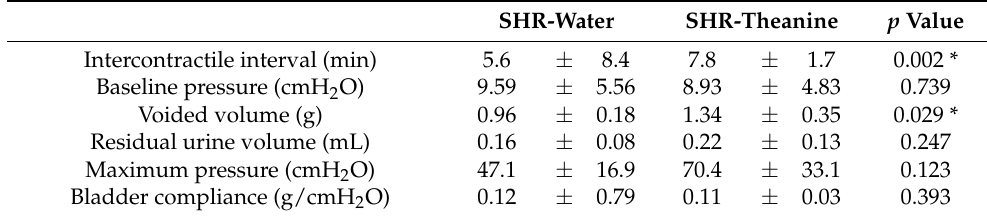
Table 3. Cystometory parameters in the SHR–water and SHR–theanine groups. * Statistical signifi- cance at the p < 0.05